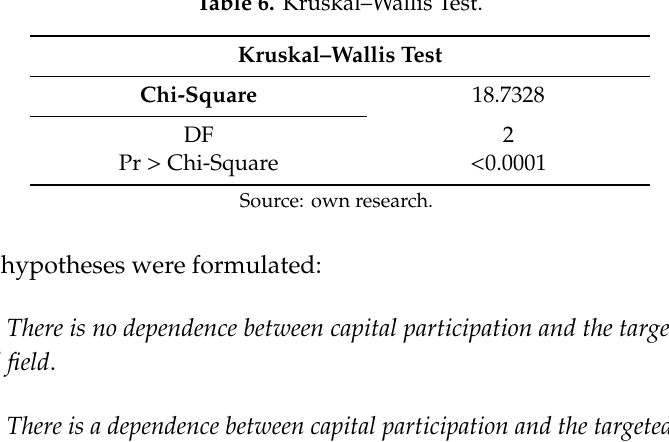
Table 6. Kruskal–Wallis Test.